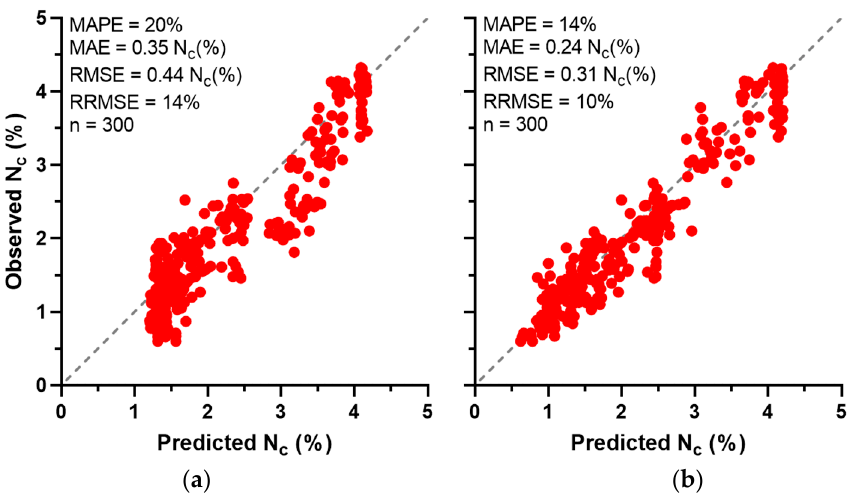
Figure 6. Validation of predictive models for plant N concentration (Nc) using vegetation indices (VI) selected from the combination of spectral bands ( a ) and sensor data fusion ( b ) (Figure 5) for the whole crop cycle. RMSE: root-mean-square error of the error. RRMSE: RMSE relative to the observed mean. MAE: the mean absolute error. MAPE: the mean absolute percent error.